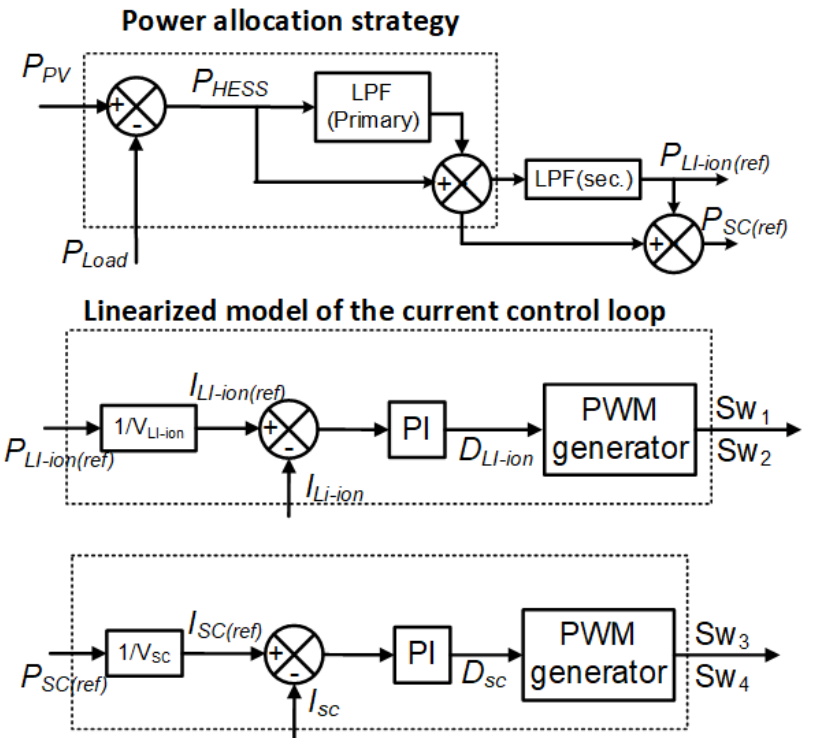
Figure 15. Power-sharing technique in three-level HESS.